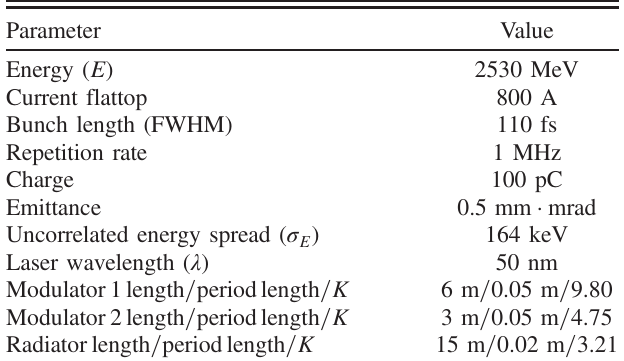
TABLE I. Parameters for